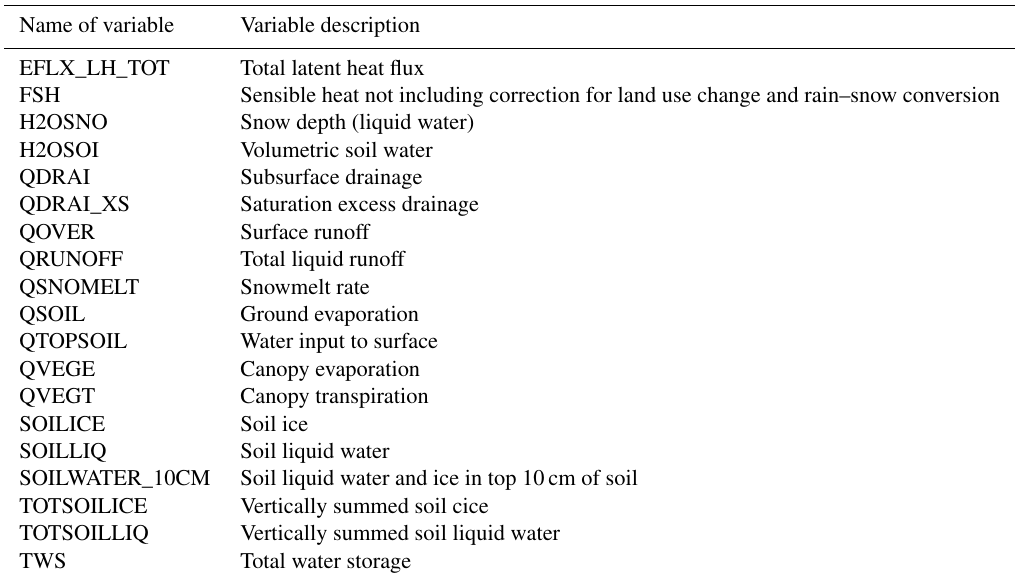
Table A8. 6-hourly averaged output from the land model in ARISE-SAI-1.5 simulations and five additional SSP2–4.5 CESM2(WACCM6) simulations. None of the above output is contained in the first five ensemble members of CESM2(WACCM6) SSP2–4.5 simulations.